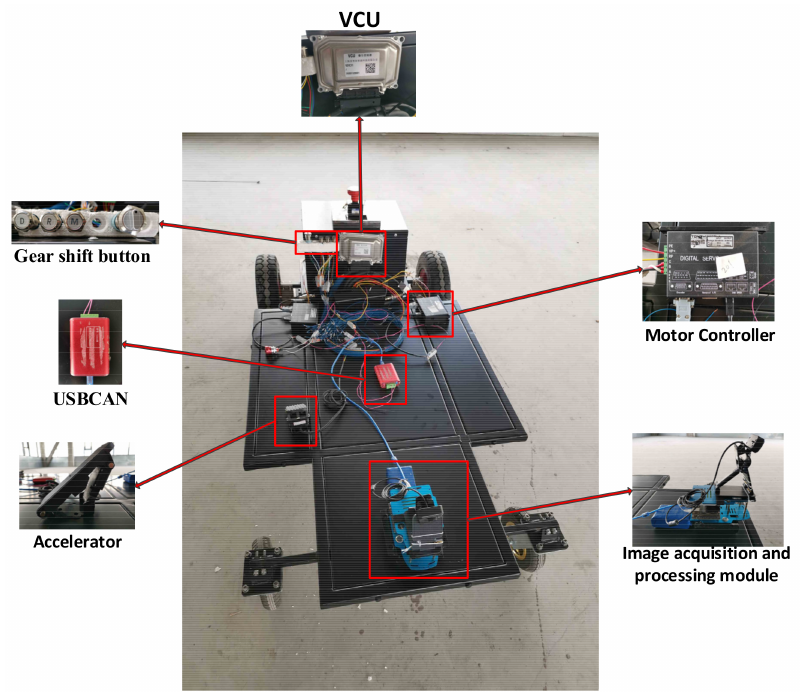
Figure 13. Hardware layout of test platform.